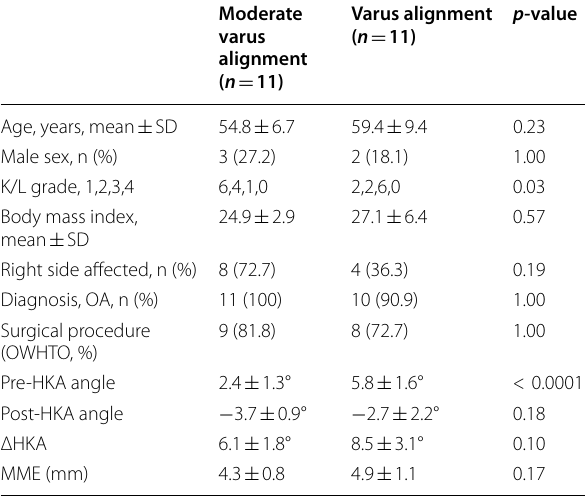
Table 1 Patient characteristics